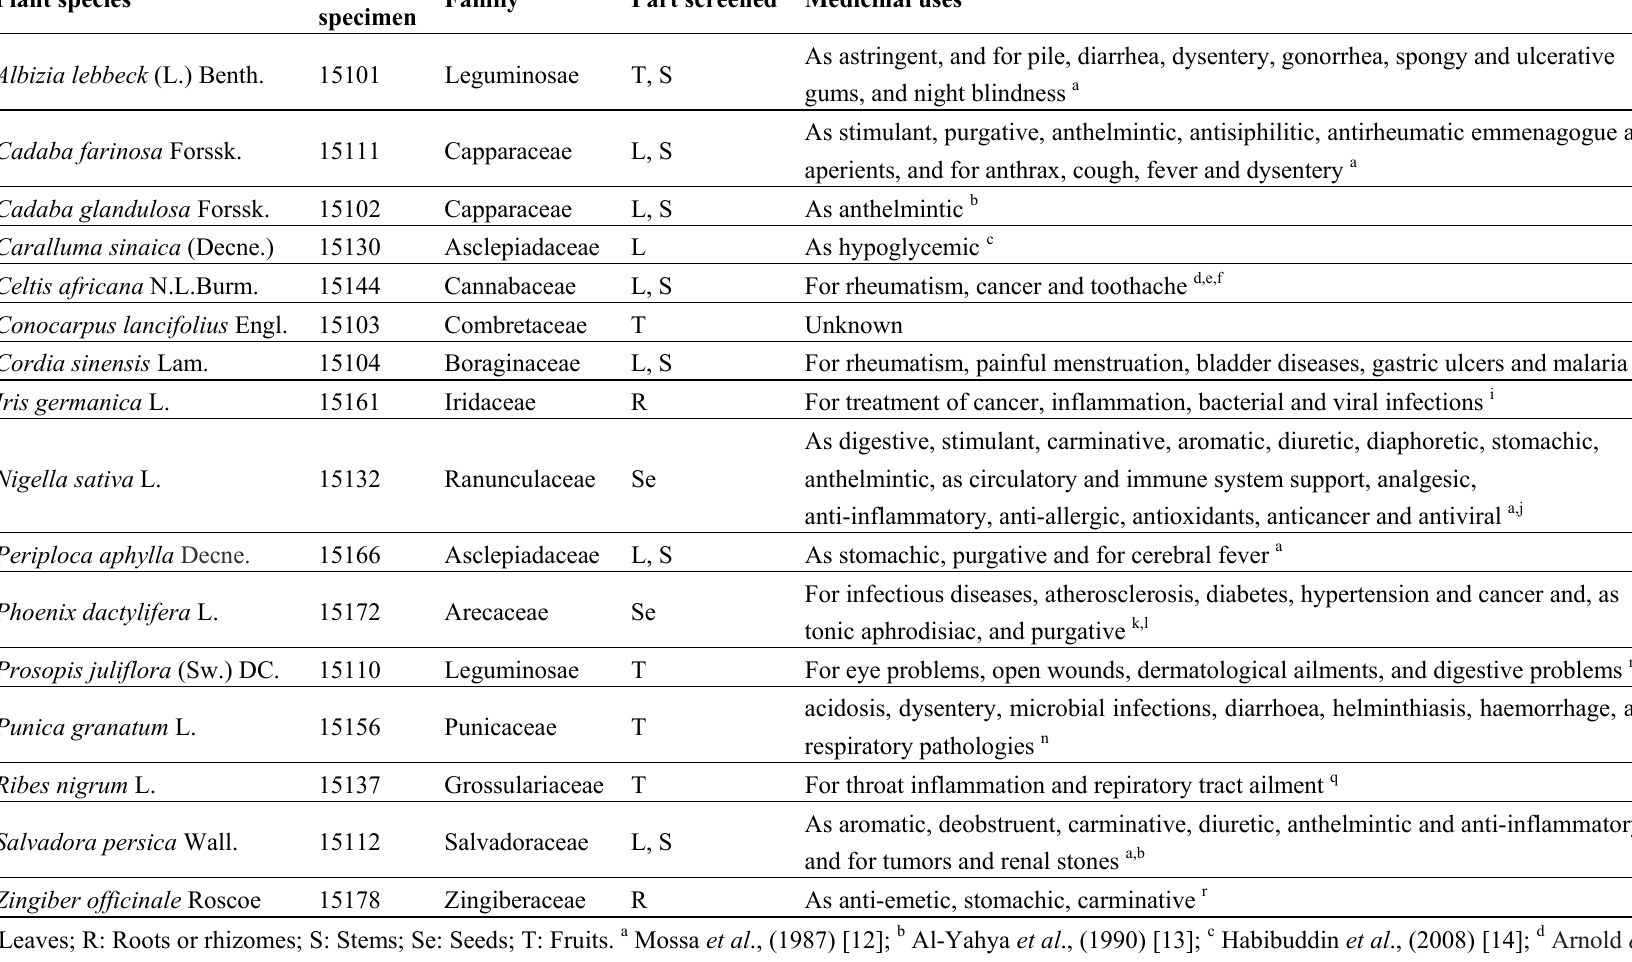
Table 1. List of plants screened and their traditional